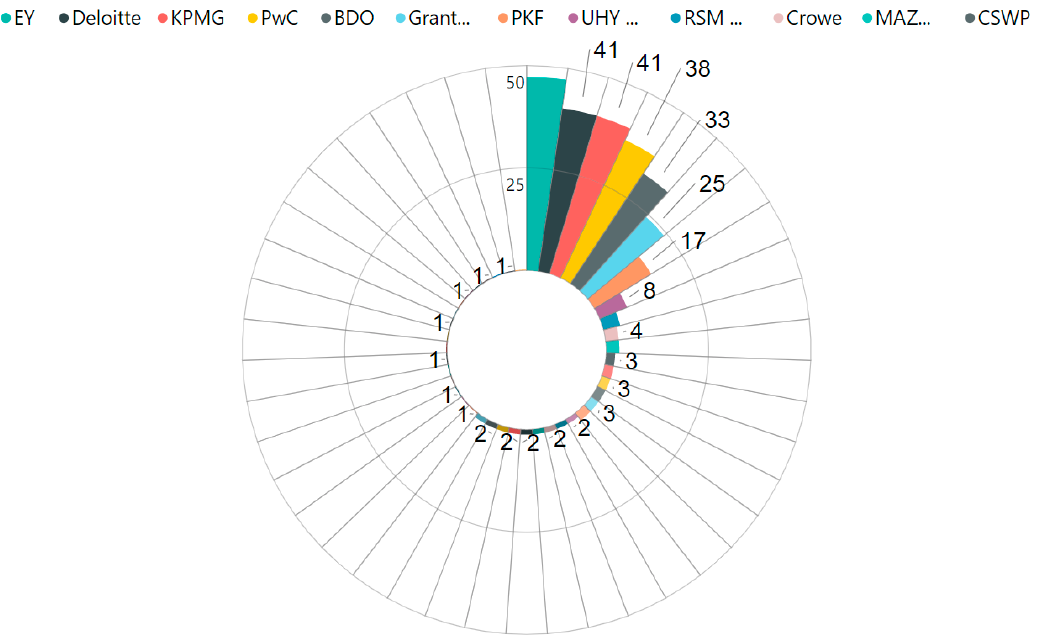
Figure 4. Structure of the tested sample in terms of the auditors. Source: own elaboration based on analyzed data.